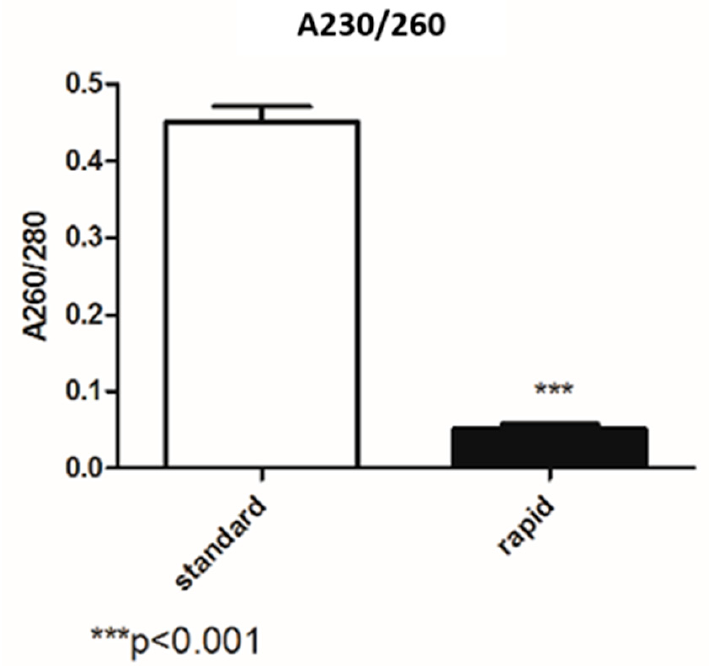
Figure 2. Comparison between the 260/280 ratio obtained by the standard and rapid extraction kits. In Figure 3, we compared the 260/230 ratio and, with both kits, it was very low. The difference in terms of the 260/280 ratio between the two methods was statistically significant ( p > 0.001).